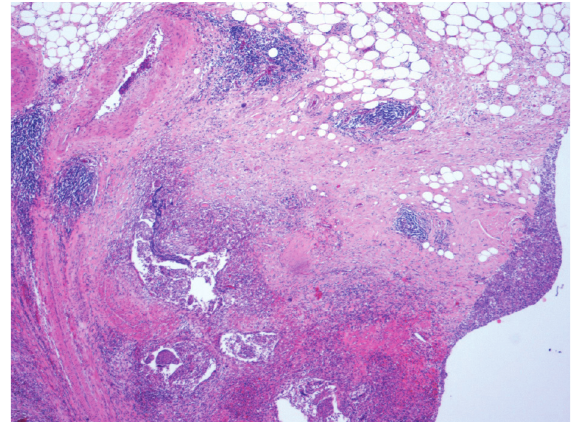
Figure 5. Low power view (×4 objective lens) of Hematoxylin and Eosin (H and E) stained bladder resection specimen showing focal invasion of tumour into peri-vesical fat.